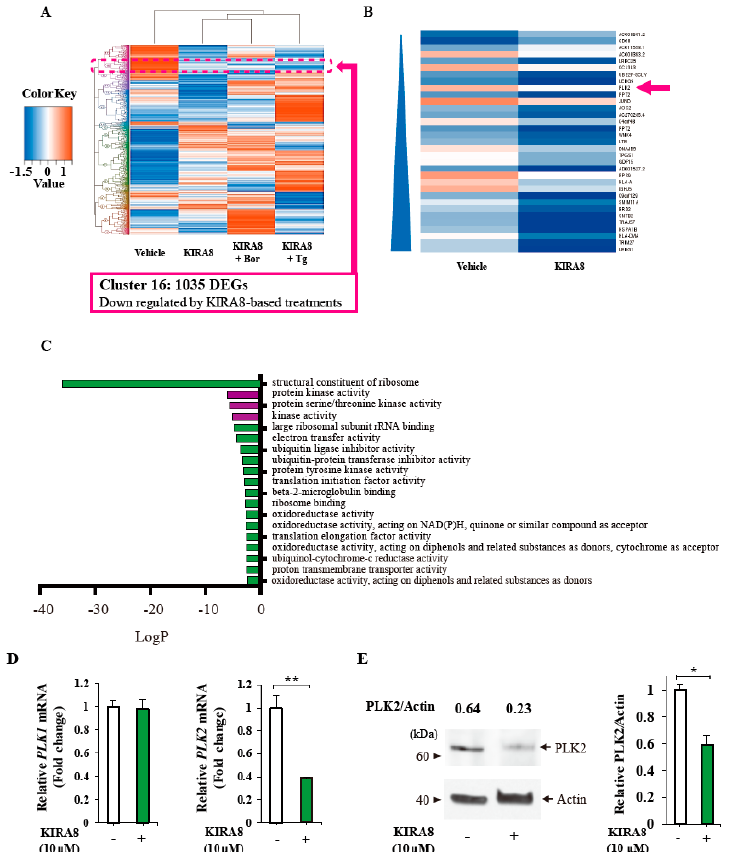
Figure 5. The gene expression profile by KIRA8 in human myeloma cells. ( A ) IM-9 cells were treated with vehicle (DMSO), 10 µ M of KIRA8, and its combination with 5 nM of bortezomib (Bor) or 500 nM of Tg in duplicate. The heatmap shows the cluster analysis from each group. Cluster 16 (dotted frame) represents the differentially expressed genes (DEGs) suppressed by KIRA8-based treatments. ( B ) The gene list shows the top 30 downregulated protein-coding DEGs treated with KIRA8 alone; the most downregulated gene is at the bottom. Pink arrow, the Polo-like kinase 2 ( PLK2 ) was focused on in this study. ( C ) The list of Gene Ontology-enriched terms for molecular function in cluster 16. Terms related to PLK2 are highlighted in purple. ( D ) Quantitative RT-PCR of the relative PLK1 and PLK2 mRNA levels from IM-9 cells treated with vehicle (DMSO) or 10 µ M of KIRA8 for 24 h. For these experiments, three independent biological samples were used. ( E ) Western blotting of protein extracts from IM-9 cells treated with vehicle (DMSO) or 10 µ M of KIRA8 for 24 h using anti-PLK2 antibodies. Numbers above the representative western blotting picture denote the signal intensity ratios of PLK2 and β -actin measured by Image J software. The β -actin level was used as an internal control. For statistical analysis, three independent biological samples data were used. The data shown are the mean ± SEM. *, p < 0.05; **, p <